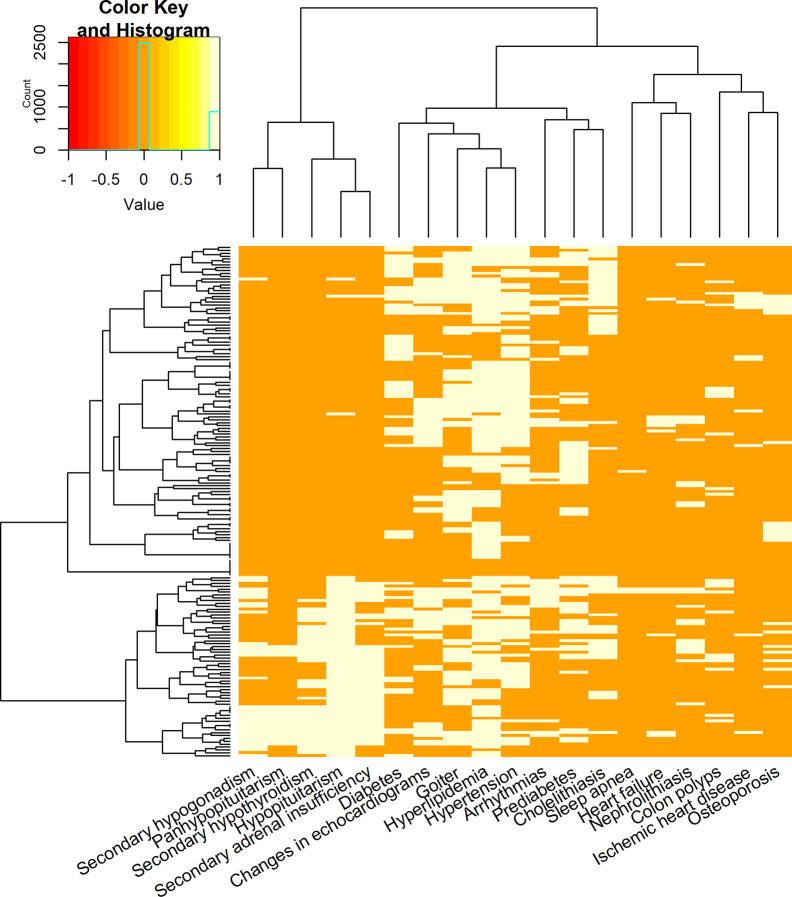
Heatmap of particular complications co-occurrence. Each row in the heatmap denotes a patient. Each column is a complication. Bright fields mark complications that a patient suffered from. In addition, the dendrograms on the left-hand side and the top panel present grouping of patients, and grouping of complications, respectively.